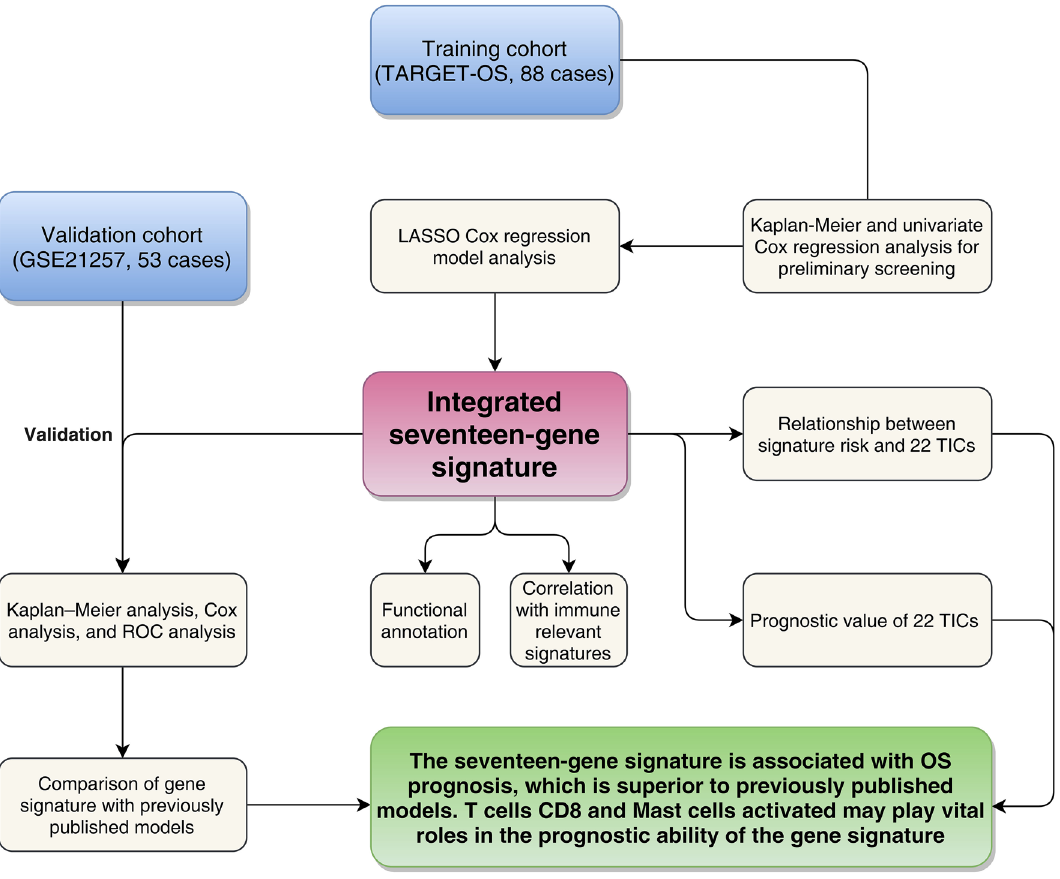
Figure 1. Flow chart of the study. LASSO least absolute shrinkage and selection operator Cox regression model, ROC receiver operating characteristic, OS osteosarcoma, TICs tumor-infiltrating immune